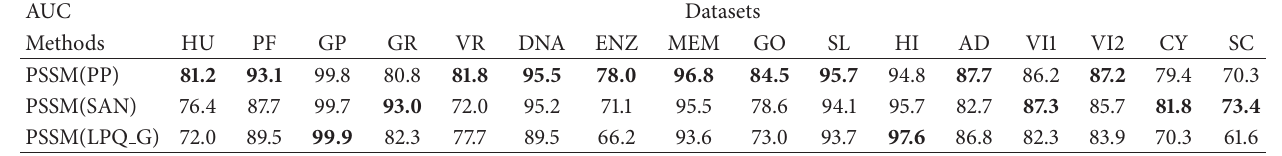
Table 12: Comparison among ensembles and best stand-alone descriptors in terms of AUC.